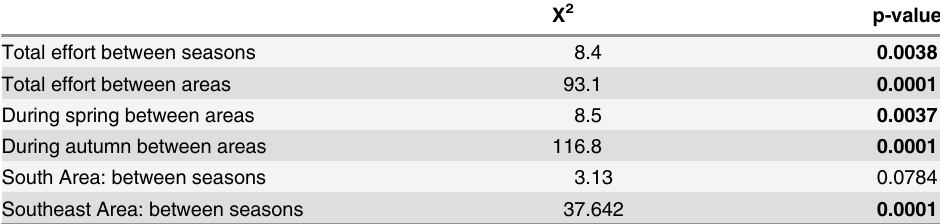
Table 3. Differences in survey effort tested between areas and seasons using Chi-square test (X 2